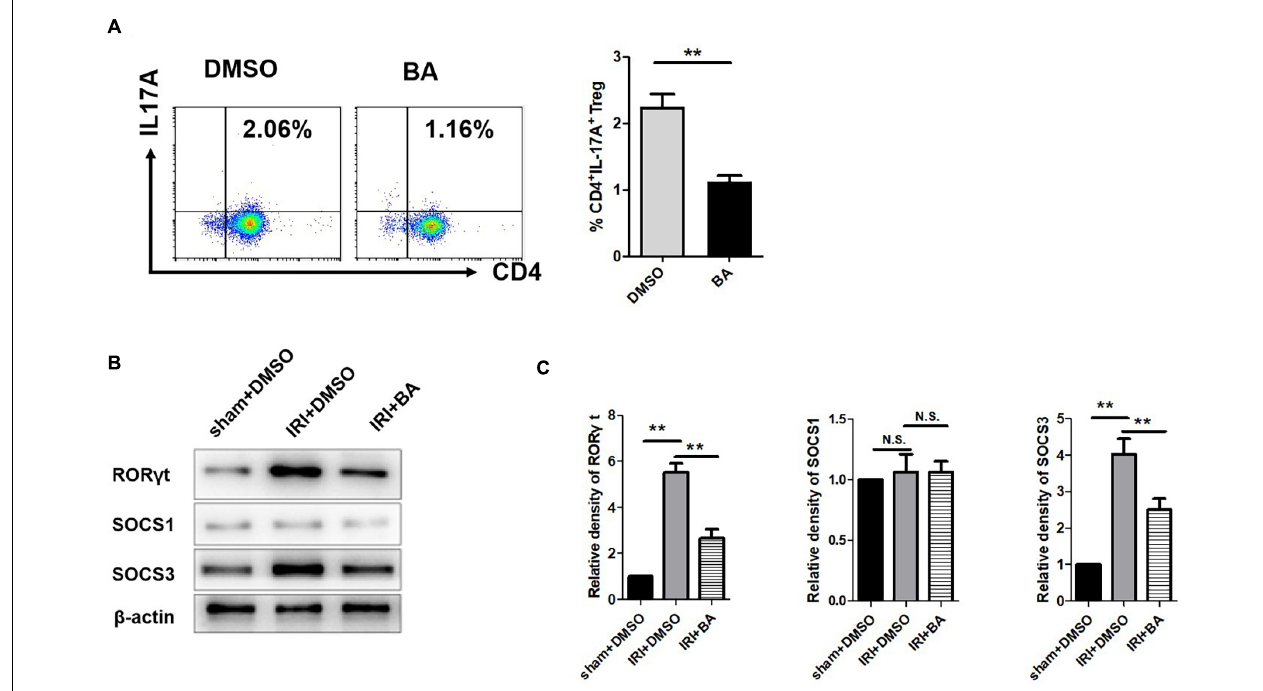
FIGURE 3 | BA regulates Treg/Th17 balance by targeting SOCS3 but not SOCS1 in renal IRI. (A) The frequency of Th17 cells in the BA treatment group was significantly reduced. (B,C) The expression of ROR γ t and SOCS3, but not SOCS1 was decreased after BA treatment. Sample size = 3 in each group. Data were presented as mean ± standard deviation. N.S. P > 0.05, * P < 0.05, ** P <